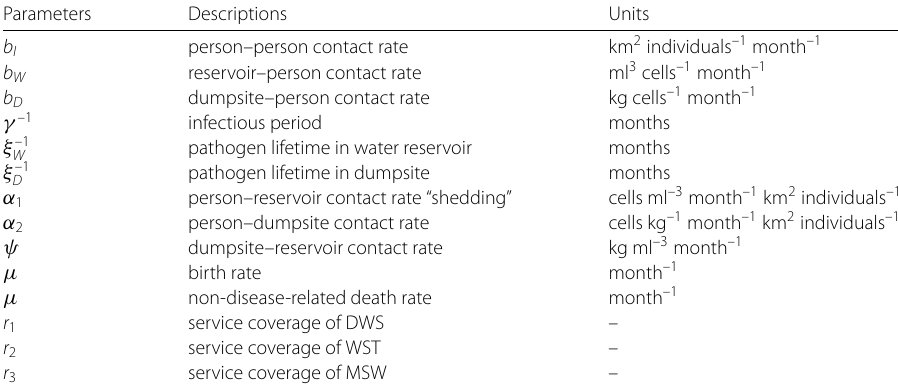
Table 2 Description of model parameters and units for SIWDR model